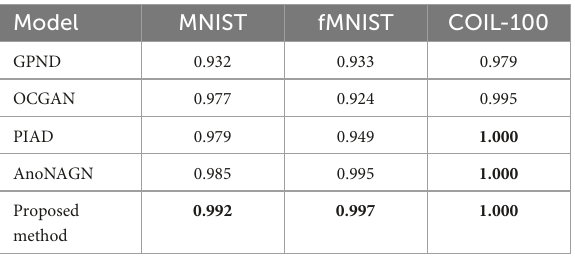
TABLE 1 Average receiver operating characteristic curve (ROC) area under curve (AUC) for anomaly detection on fMNIST and COIL-100. Model MNIST